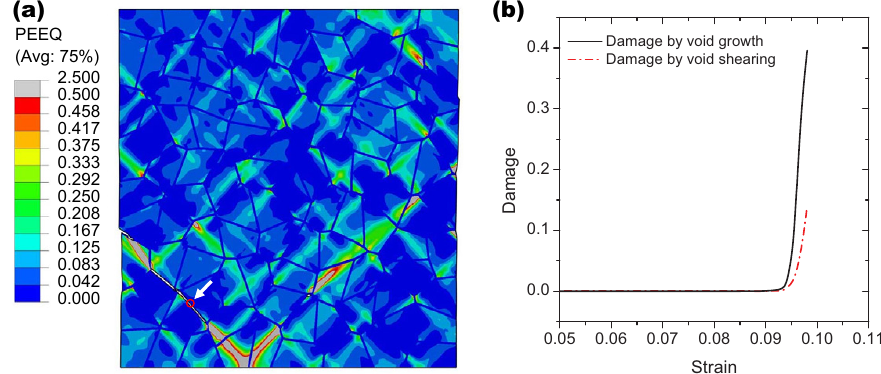
Figure 6. ( a ) the distribution of the equivalent plastic stain (PEEQ) within the grains under the uniaxial tension and ( b ) the corresponding damage evolution of one Gaussian point located in the red circle for both void growth and void